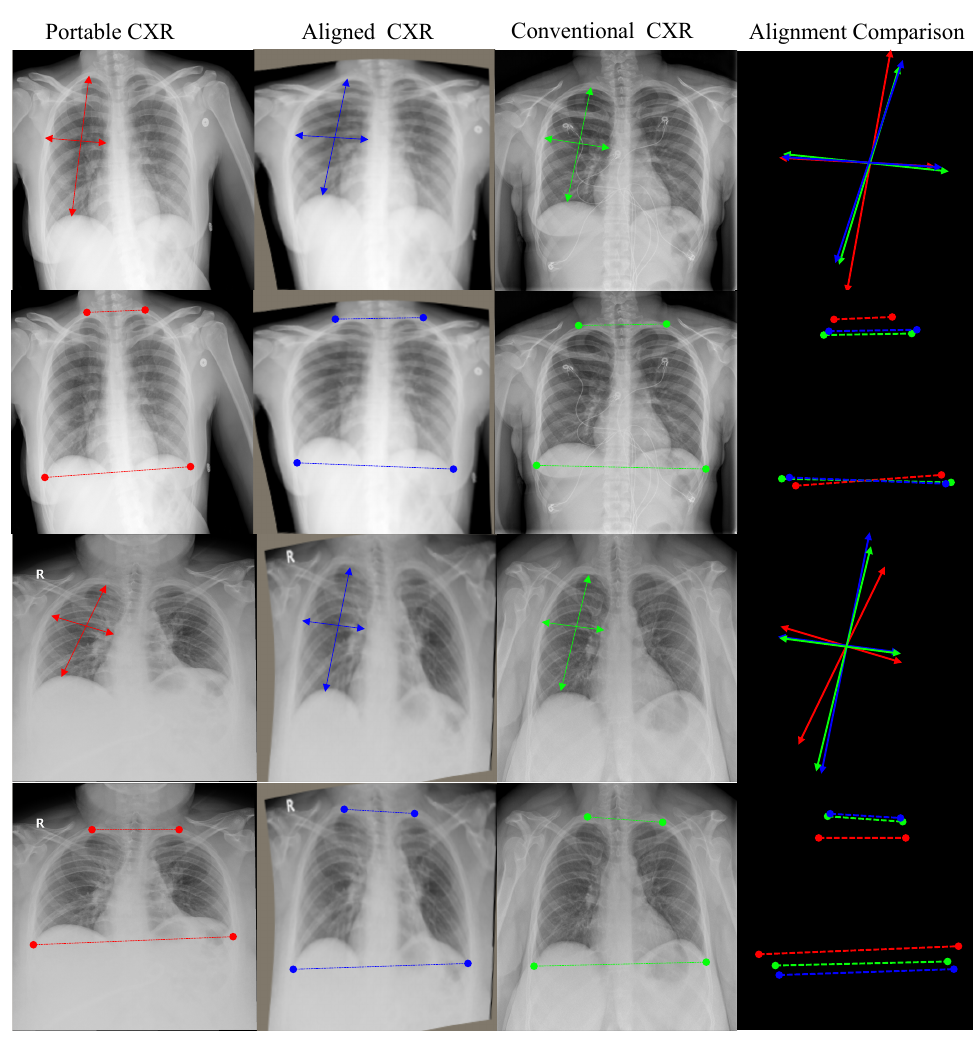
Figure 8. Some illustrations of our aligning results. From left to right—the first column: portable radiographs; the second column: aligned radiographs by our model; the third column: conventional radiographs which are used to compare; the fourth column: comparison between the original portable CXR, the conventional CXR and our aligned results in terms of topological information. From top to bottom—the first and second rows are the aligning results of the first subject and the third and fourth rows are the aligning results of the second subject. The first and third rows are for local topological comparison and the second and fourth rows are for global topological comparison. Table 1. MAE of CXR alignment on left lung, right lung and both